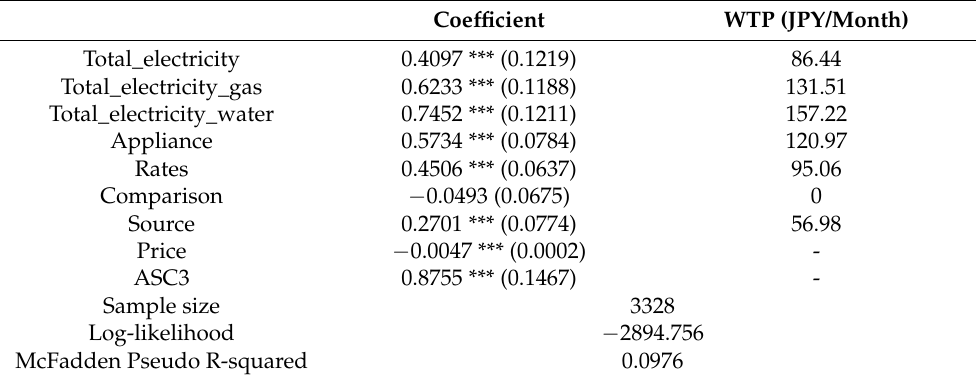
Table 3. Estimation results of the conditional logit